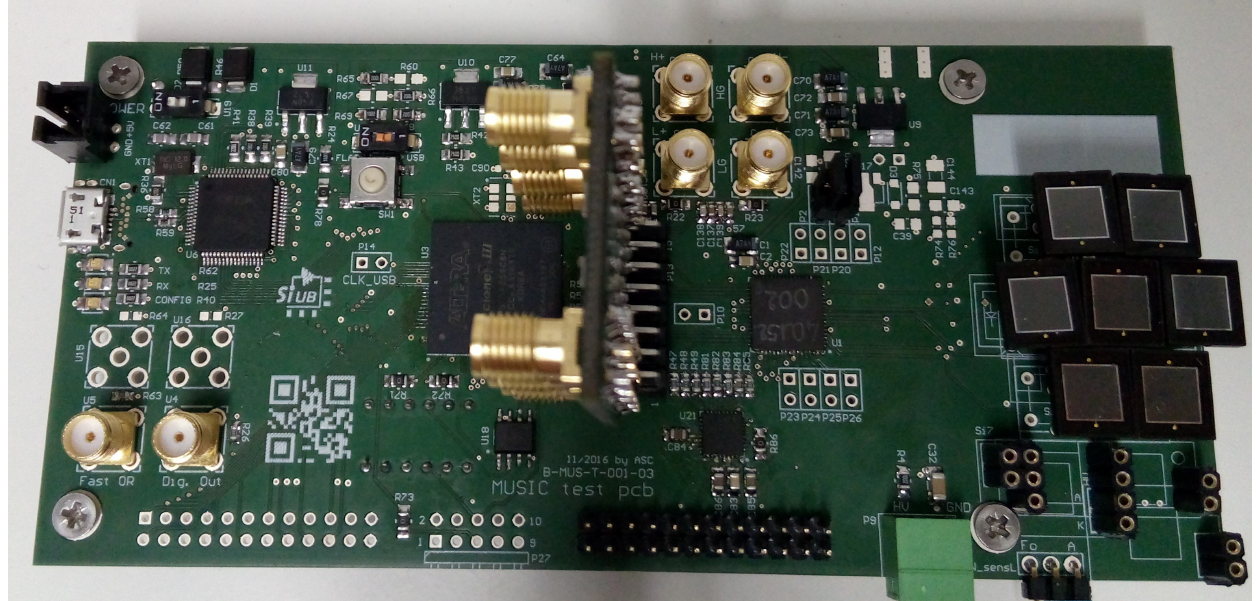
Figure 7. Printed Circuit Board (PCB) containing mainly the MUSIC ASIC, an Altera Cyclone III FPGA, power regulators, and connectors. It also illustrates how to connect 7 Hamamatsu SiPMs S13360 − 6050CS to show the performance of the summation circuit. The PCB measures 144.75 × 67.66 mm 2 .